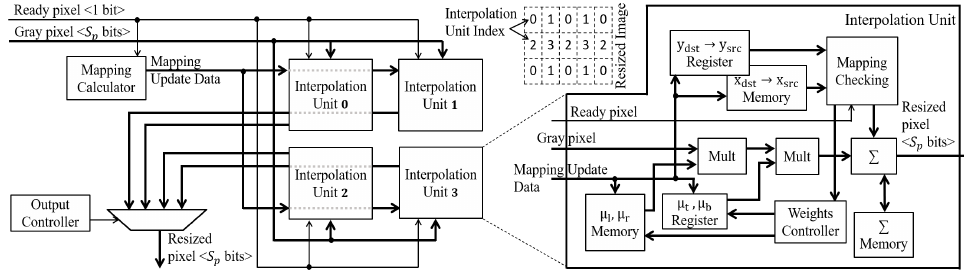
Figure 6. The resize architecture. The term Mult means